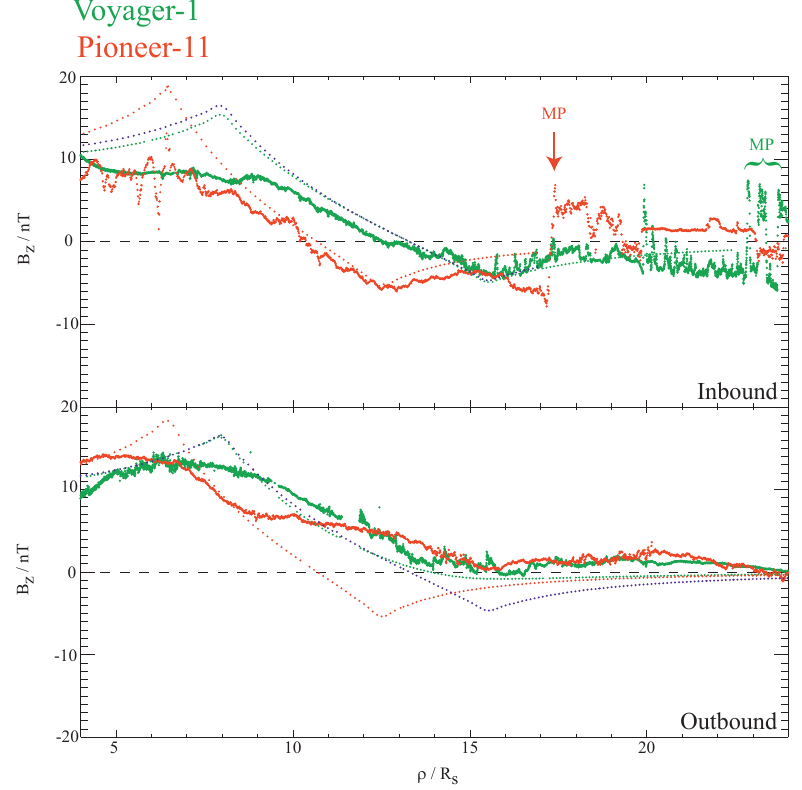
Fig. 6. Comparison of the residual B z fields observed by Pioneer-11 (red) and Voyager-1 (green), plotted versus cylindrical radial distance ρ between 4 and 24 R S . The top panel shows the residuals observed on the inbound passes (at ∼ 12:00 and ∼ 13:00LT for Pioneer-11 and Voyager-1, respectively), while the bottom panel shows those observed on the outbound passes (at ∼ 06:00 and ∼ 03:00LT, respectively). Inbound magnetopause crossings are also marked in the upper panel (none occurred within the range on the outbound passes). The dotted lines also show the fields of the fitted model ring currents. The model field for Voyager-1 (green) is that derived by Connerney et al. (1983), as described in the text and caption to Fig. 3, while the model for Pioneer-11 (red) is that derived here, as described in the text and caption to Fig. 5. The purple dotted line shows the results for the Connerney et al. (1983) model derived for the Pioneer-11 trajectory, which does not provide a good